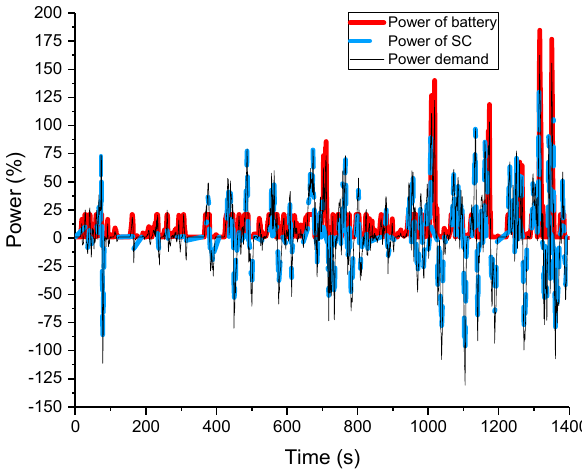
Figure 14. Power distribution results based on the rule-based strategy.